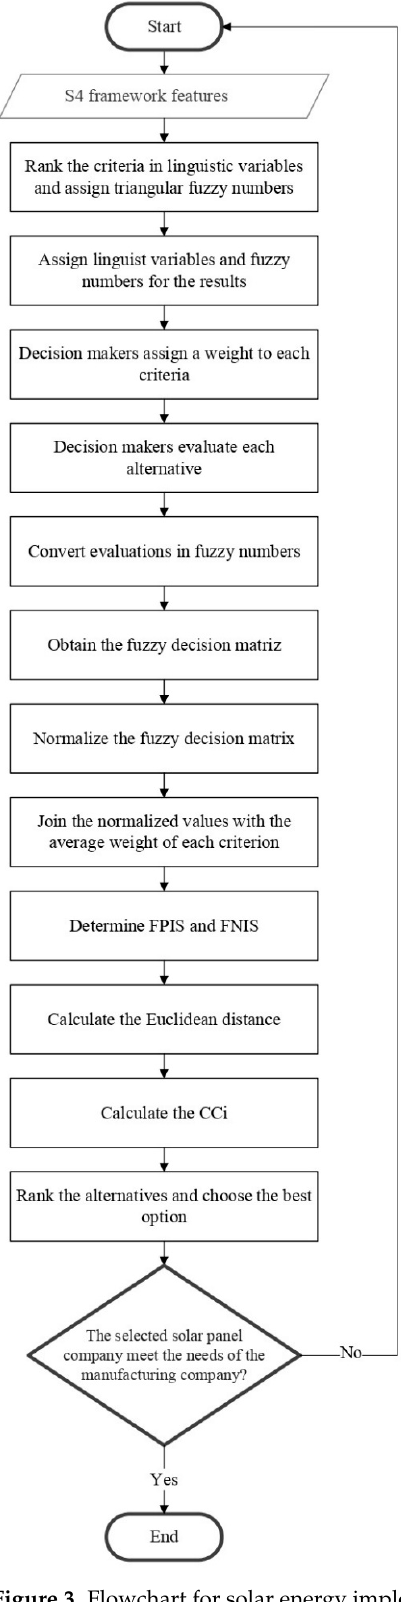
Figure 3. Flowchart for solar energy implementation in the manufacturing industry using the Fuzzy TOPSIS method and the S4 Framework.